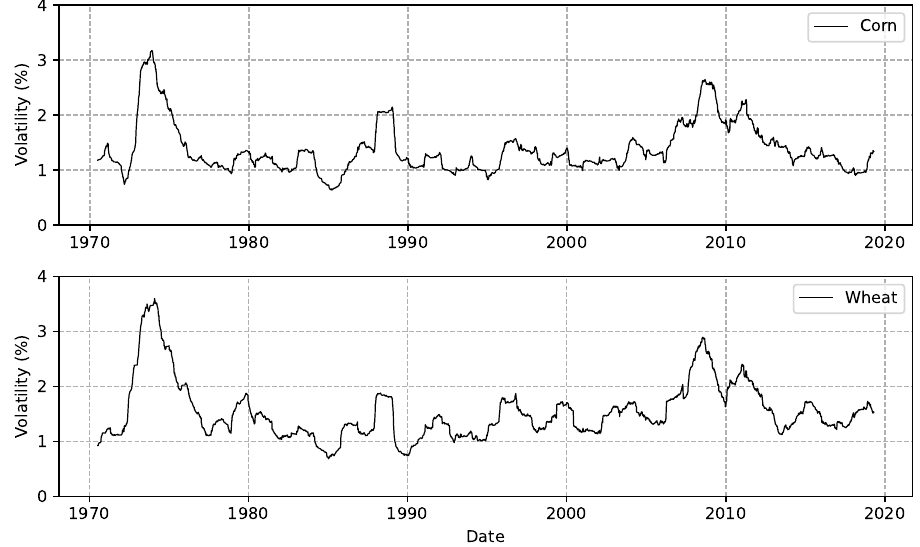
Figure 6. Standard deviations of price changes for corn ( top panel ) and wheat ( bottom panel ) using a rolling window covering 275 trading days, 1970–2019.